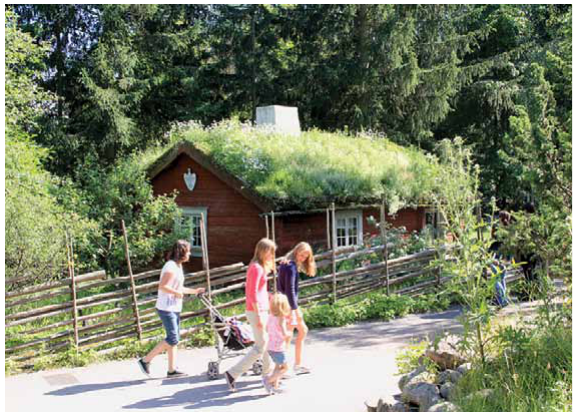
fig. 3. Traditional Scandinavian biodiverse green roofs, Stockholm, Skansen